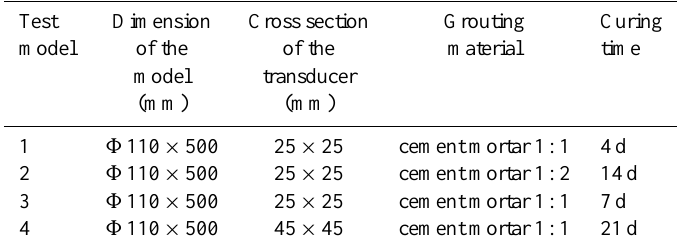
Table 2. Parameters of test model. Test Dimension Cross section Grouting Curing model of the of the material time model transducer (mm) (mm) 1 8 110 × 500 25 × 25 cement mortar 1 : 1 4d 2 8 110 × 500 25 × 25 cement mortar 1 : 2 14d 3 8 110 × 500 25 × 25 cement mortar 1 : 1 7d 4 8 110 × 500 45 × 45 cement mortar 1 : 1